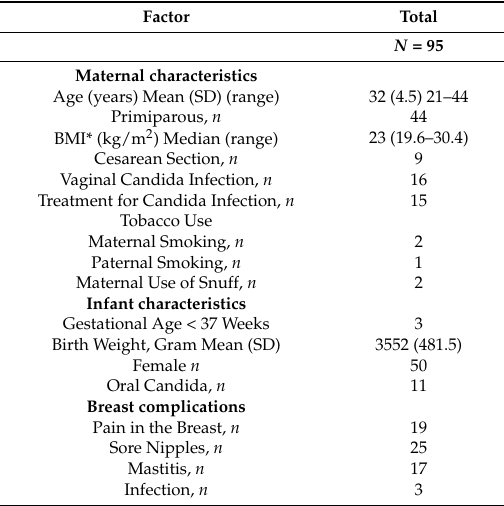
Table 1. Maternal and infant characteristics.